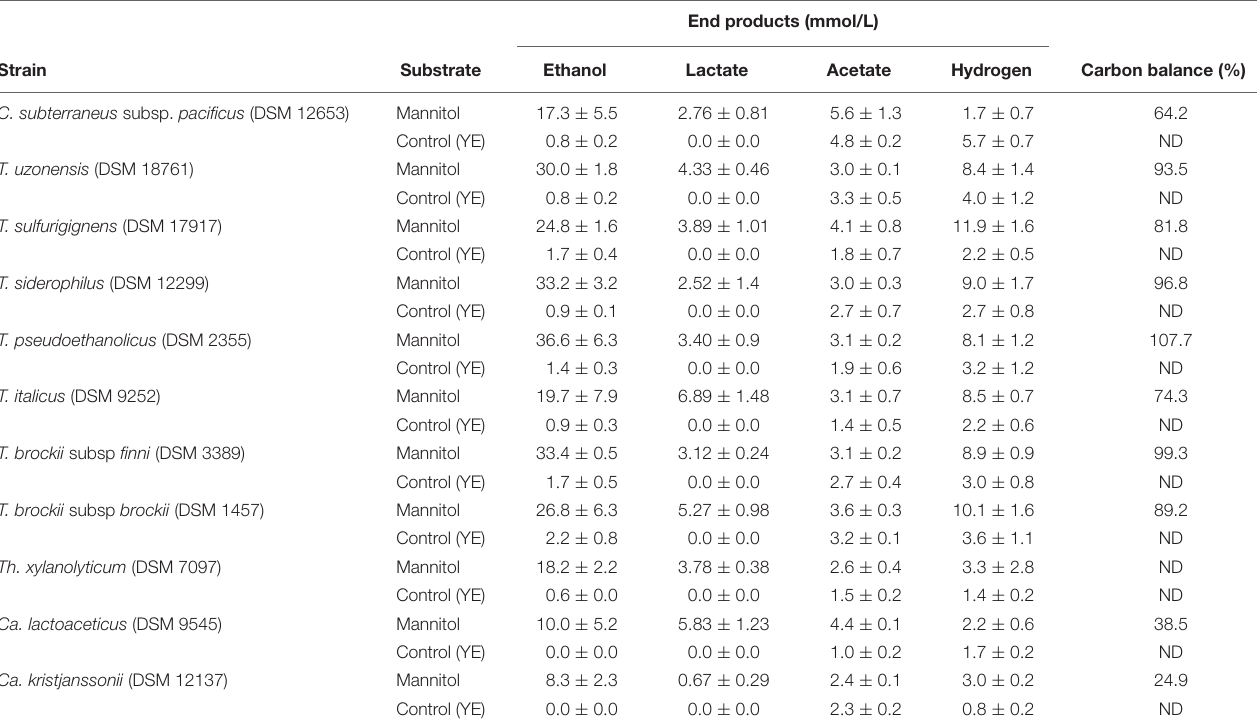
All values represent triplicate analyses of single extraction solutions with SD presented as error bars. TABLE 3 | End product formation from strains degrading mannitol (20